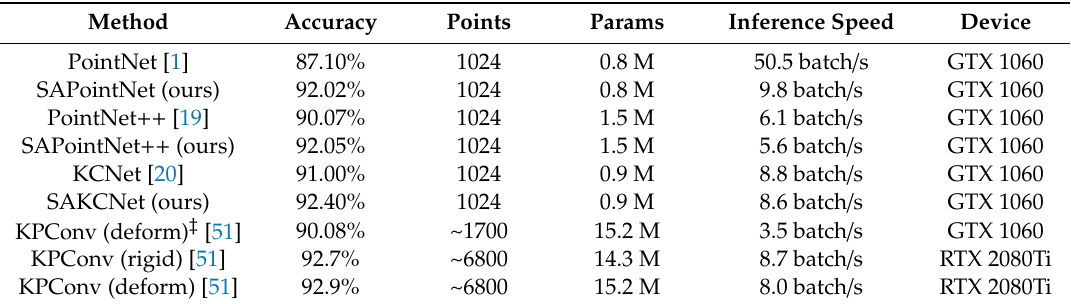
Table 1. Object classification results on the ModelNet40 dataset with di ff erent methods. For comparison, results of another method KPConv [51] using a similar conception of 3D kernels are also listed. The batch size for network inference is set as 16 for all